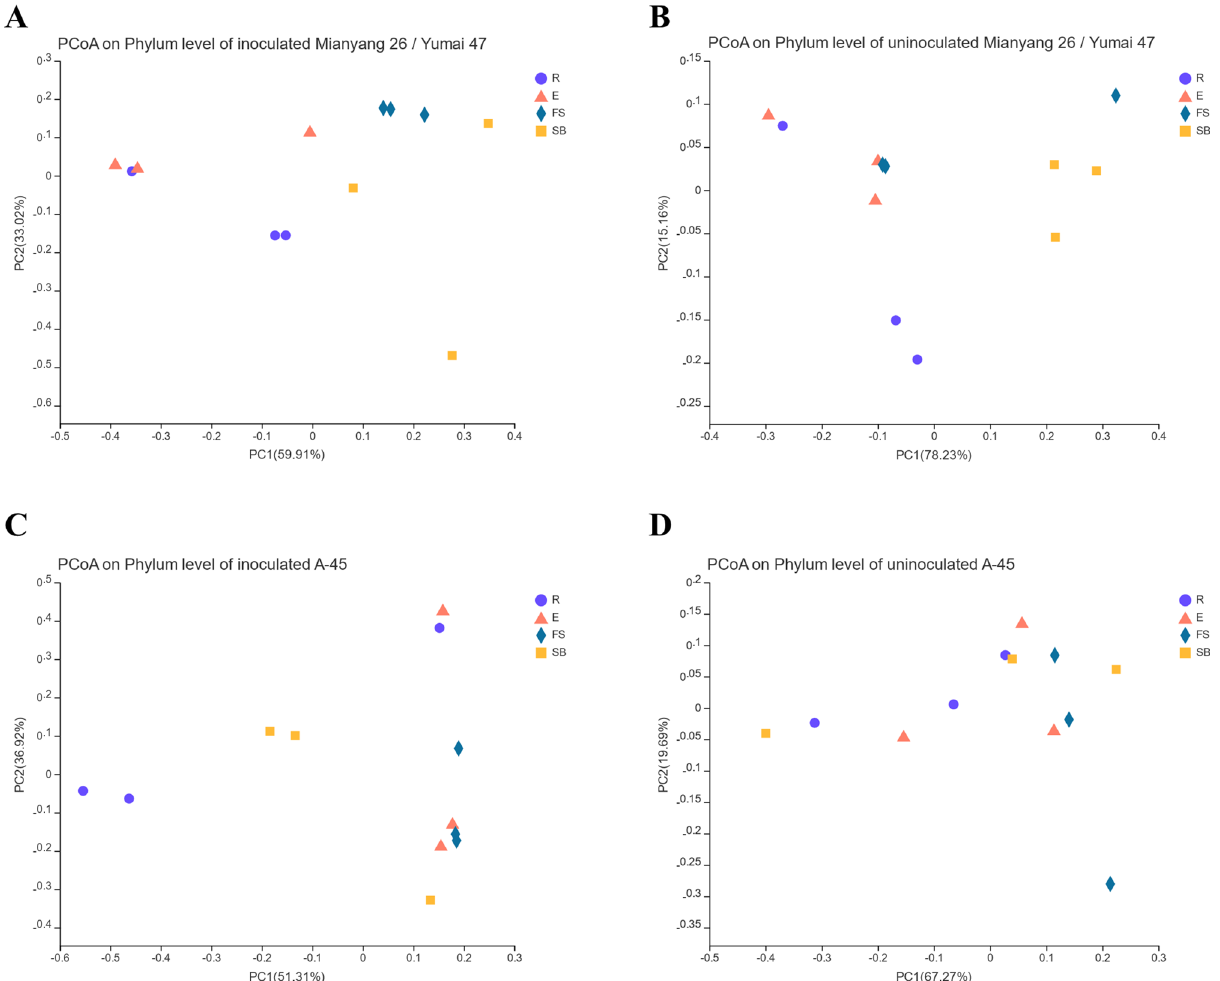
Figure 4. Bray–Curtis metrics-based principal coordinate analysis (PCoA) analysis of the endophytic bacteria (phylum level) in various tissues of different wheat varieties. ( A ) Analysis of differences between groups of endophytes in Mianyang 26/Yumai 47 inoculated with T. controversa . ( B ) Analysis of differences between groups of endophytes in Mianyang 26/Yumai 47 not inoculated with T. controversa . ( C ) Analysis of the difference between the endophytes in A-45 inoculated with T. controversa. ( D ) Analysis of differences between groups of endophytes in A-45 not inoculated with T. controversa . R, root; E, ear; FS, first stem under the ear; SB, stem